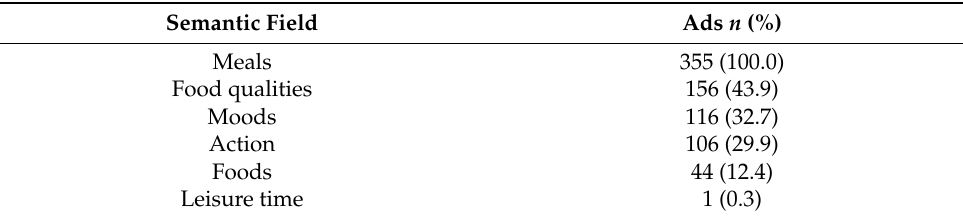
Table 3. Classification of the ads by semantic